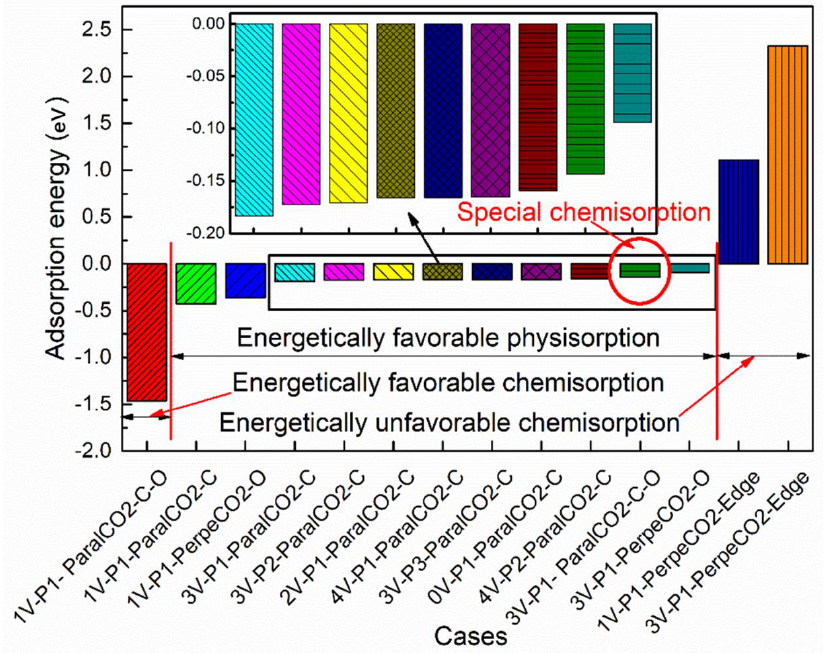
Figure 3. The adsorption energies of all the cases studied, with an increased order of adsorption energy. The inserted image is an amplification of the selected region showing the differences in physisorption energies.